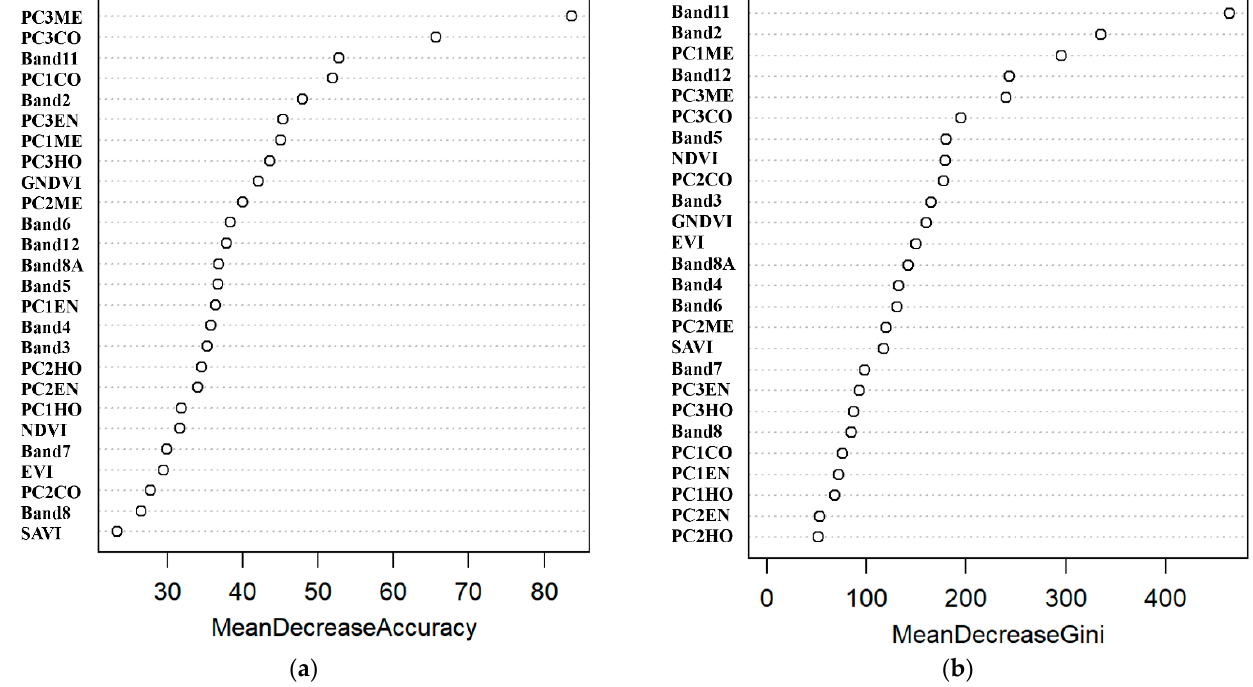
Figure 5. Band importance ranking based on: ( a ) mean decrease accuracy and ( b ) mean decrease